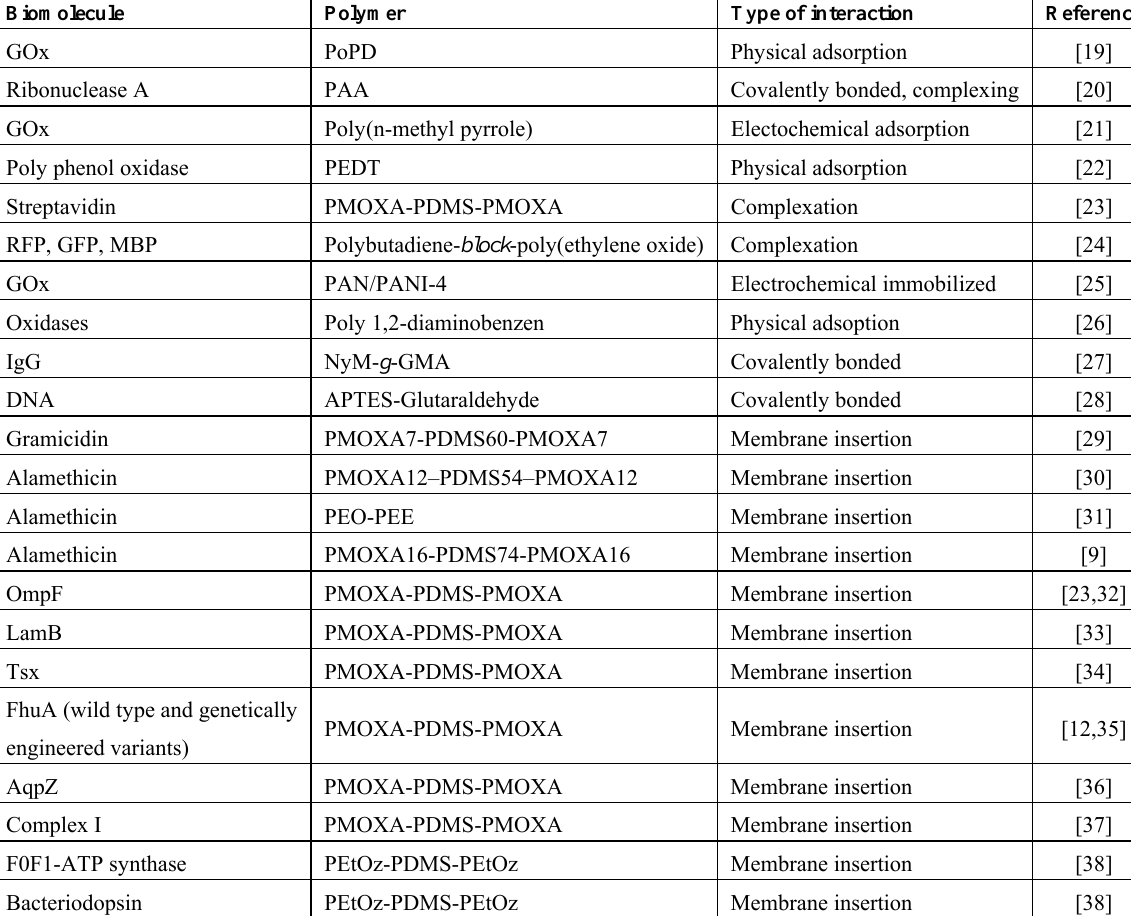
Table 1. Overview of biomolecules with their interacting